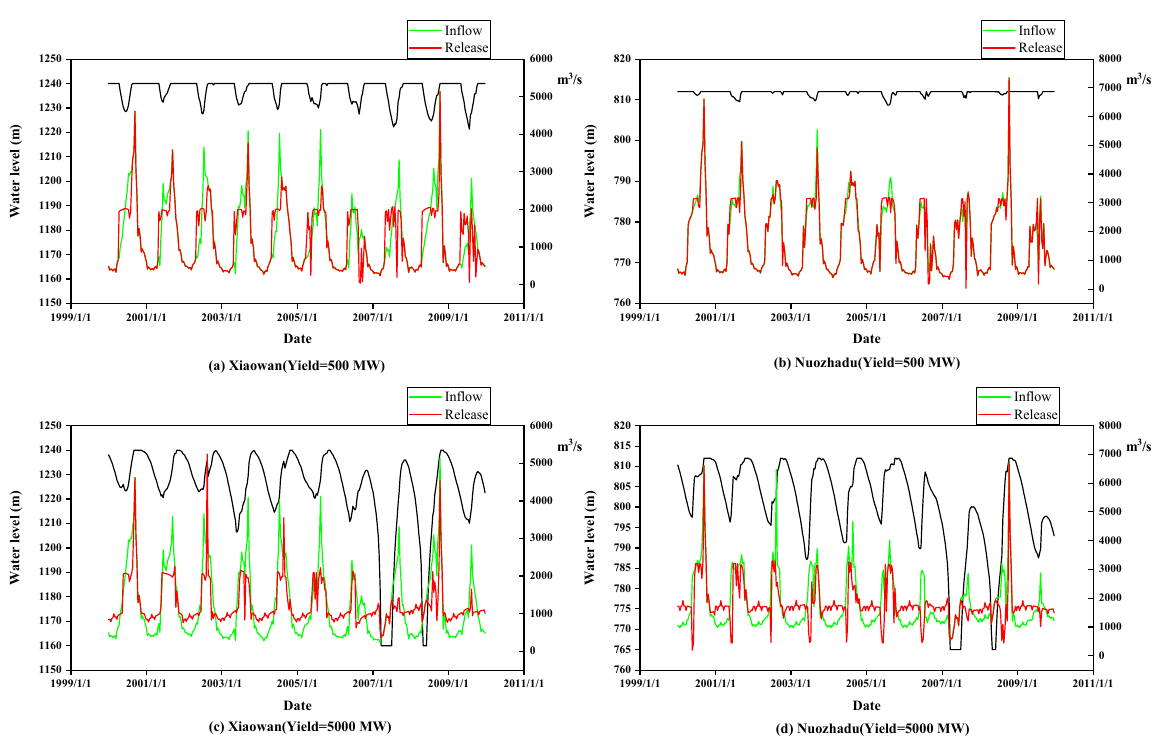
Figure 3. Water level, inflow, and release process of cascade reservoir for SDP-3 with power yield = 500 MW and 5000 MW during 2000–2009.